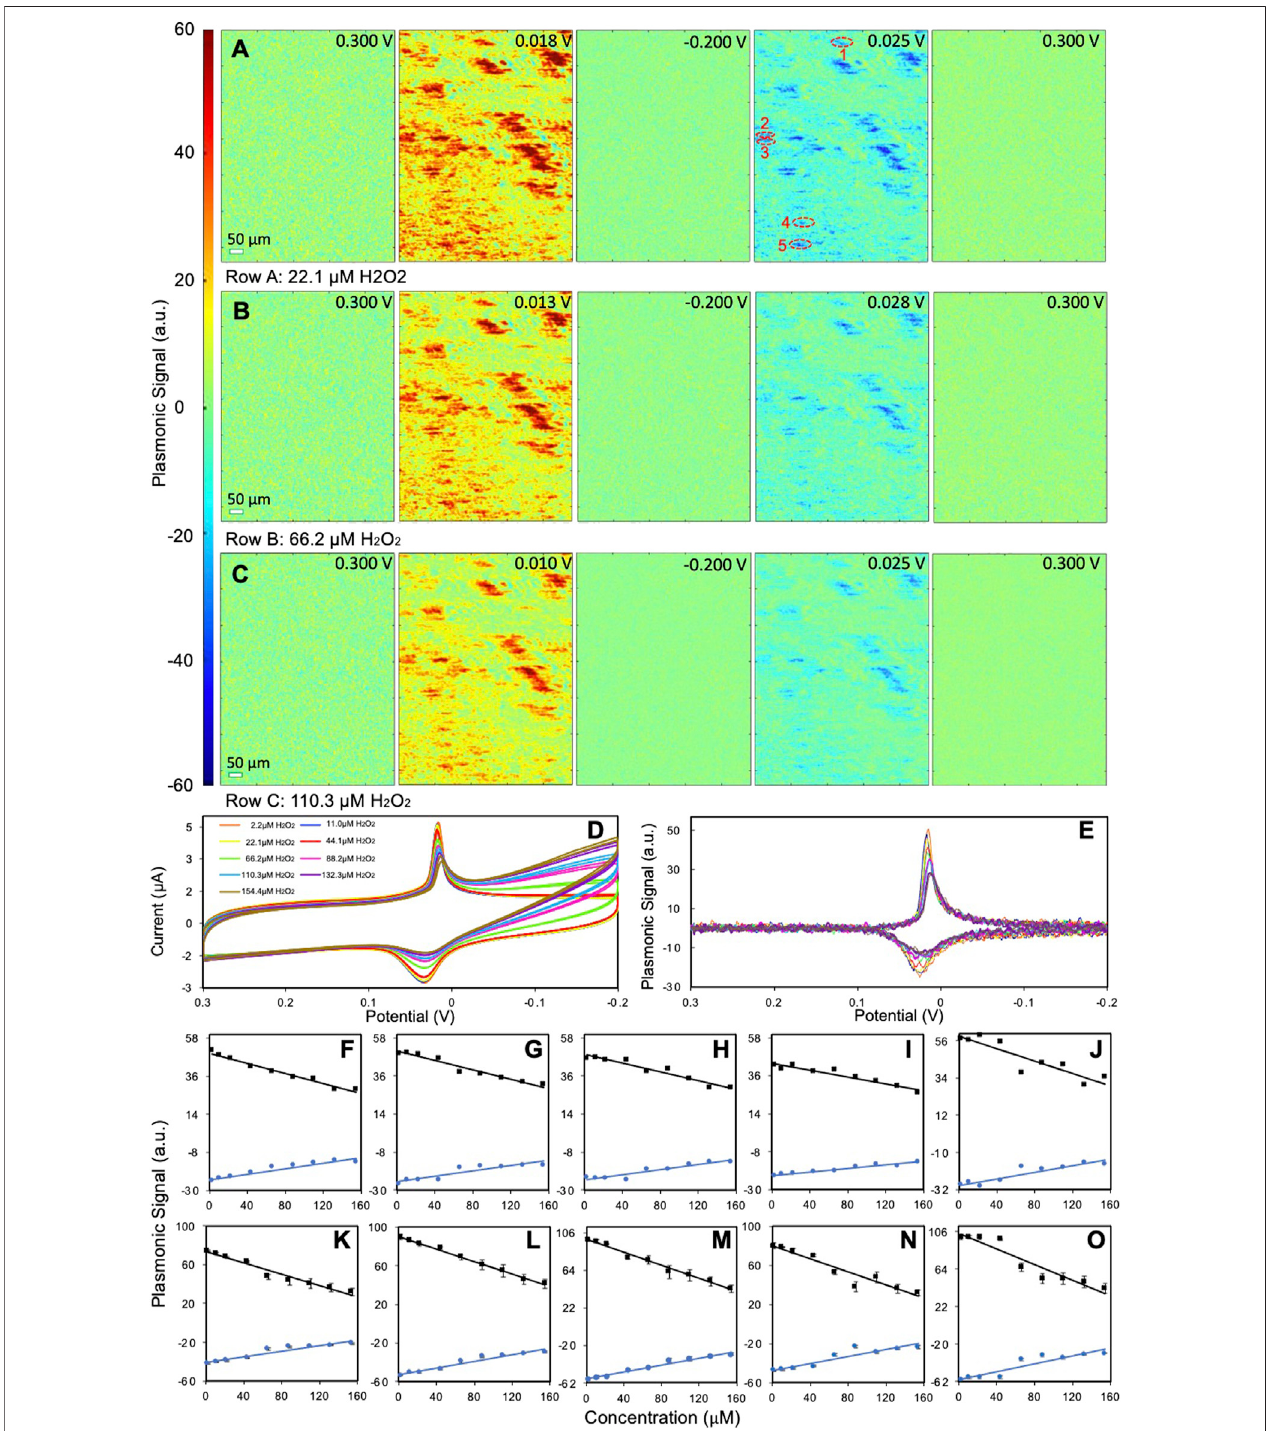
FIGURE 5 | Sensing of H 2 O 2 at type I PBNPs. (A – C) Representative PEM images of type I PBNPs with the presence of (A) 22.1 µM H 2 O 2 , (B) 66.2 µM H 2 O 2 , and (C) 110.3 µMH 2 O 2 atdifferentpotentials. (D) PotentiostatCVoftheentireelectrodeand (E) plasmonicCVsfromPBNP-1labeledin (A) fordifferentH 2 O 2 concentrations as shown in the legend. (F – O) Relationship between the plasmonic signals at redox peaks and the H 2 O 2 concentrations at fi ve different PBNPs (1 – 5 labeled in A) from (F – J) one cycle at the scan rate of 0.02 V/s and four cycles at the scan rate of 0.05 V/s (K – O) , respectively. Solution: 1.0 M KNO 3 + x µM H 2 O 2 .